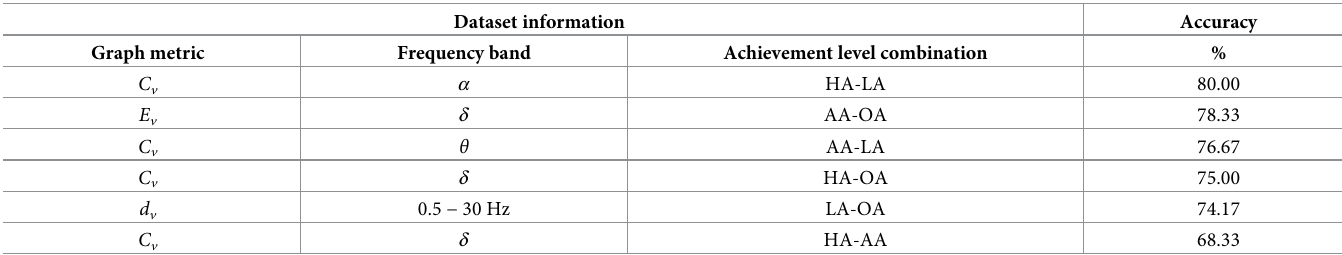
Table 4. Accuracy for the best result of the six achievement level